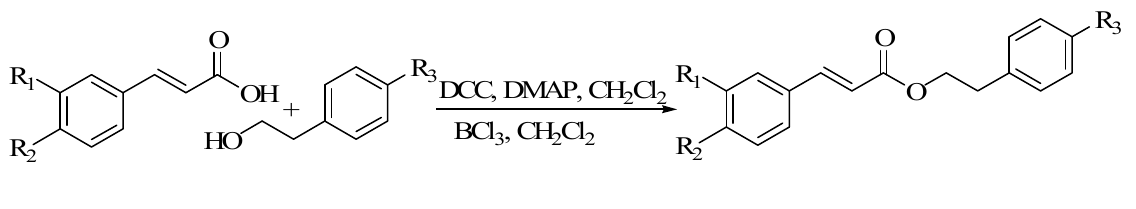
Figure 12. The scheme of synthesis of CAPE